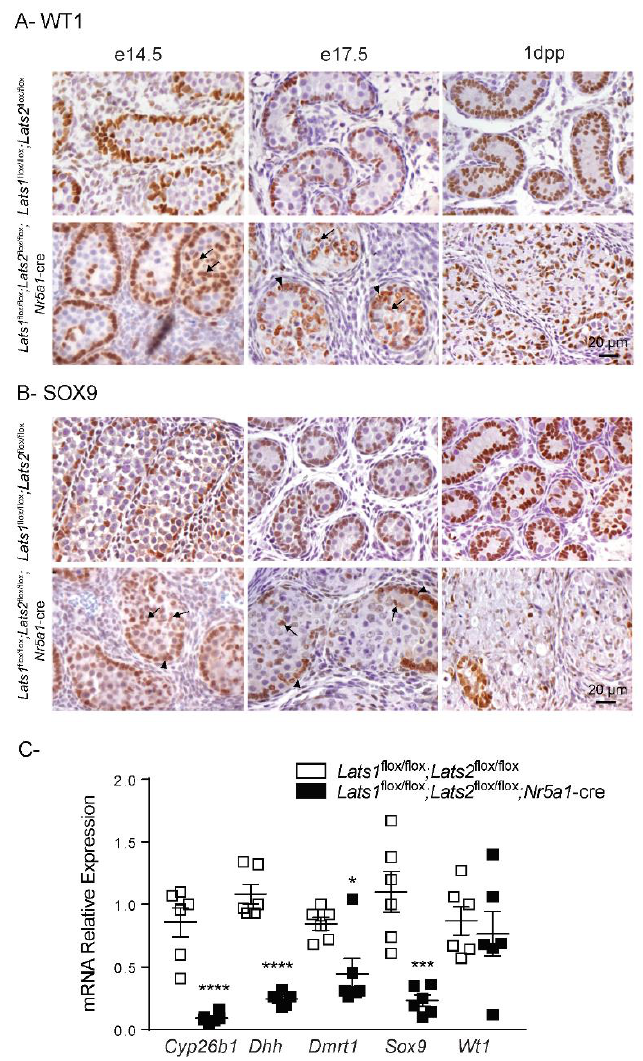
Figure 6. Loss of Lats1 and Lats2 affects expression of key Sertoli cell markers. ( A ) Immunohistochemical analysis of WT1 expression in testes of mice of the indicated genotypes. ( B ) Immunohistochemical analysis of SOX9 expression in testes of mice of the indicated genotypes. Arrow = immunopositive cells that lost their polarity. Arrowhead = immunopositive cells with normal polarity. Scale bar (lower right) is valid for all images. ( C ) RT-qPCR analysis of Sertoli cell markers in testes of 1dpp mice of the indicated genotypes ( n = 6 animals/genotype). All data were normalized to the housekeeping gene Rpl19 and are expressed as means (columns) ± SEM (error bars). Asterisks = significantly different from control (* p < 0.05; *** p < 0.001; **** p < 0.0001).